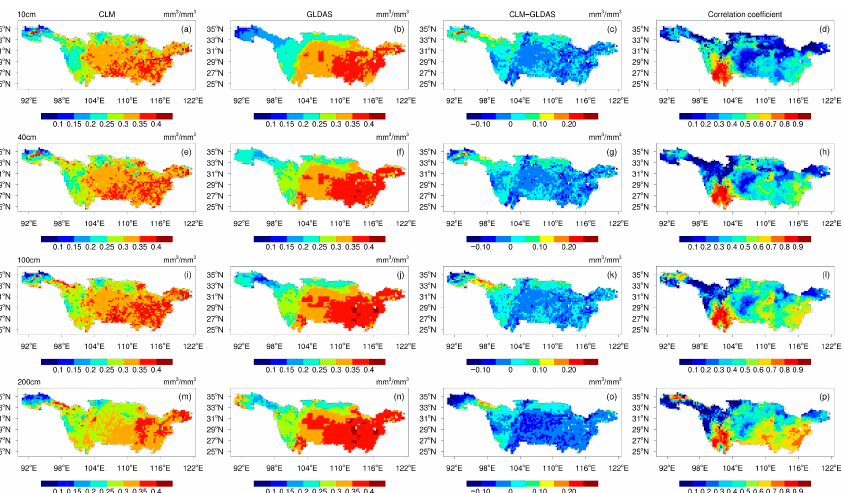
Figure 7. Spatial distribution of soil moisture of CLM and GLDAS-Noah at different soil depths. ( a , e , i , m ) is soil moisture for CLM at 10, 40, 100 and 200 cm. ( b , f , j , n ) is soil moisture for GLDAS at 10, 40, 100 and 200 cm. ( c , g , k , o ) is the differences of soil moisture between CLM and GLDAS at 10, 40, 100 and 200 cm. ( d , h , l , p ) is the correlation coefficient of soil moisture between CLM and GLDAS at 10, 40, 100 and 200